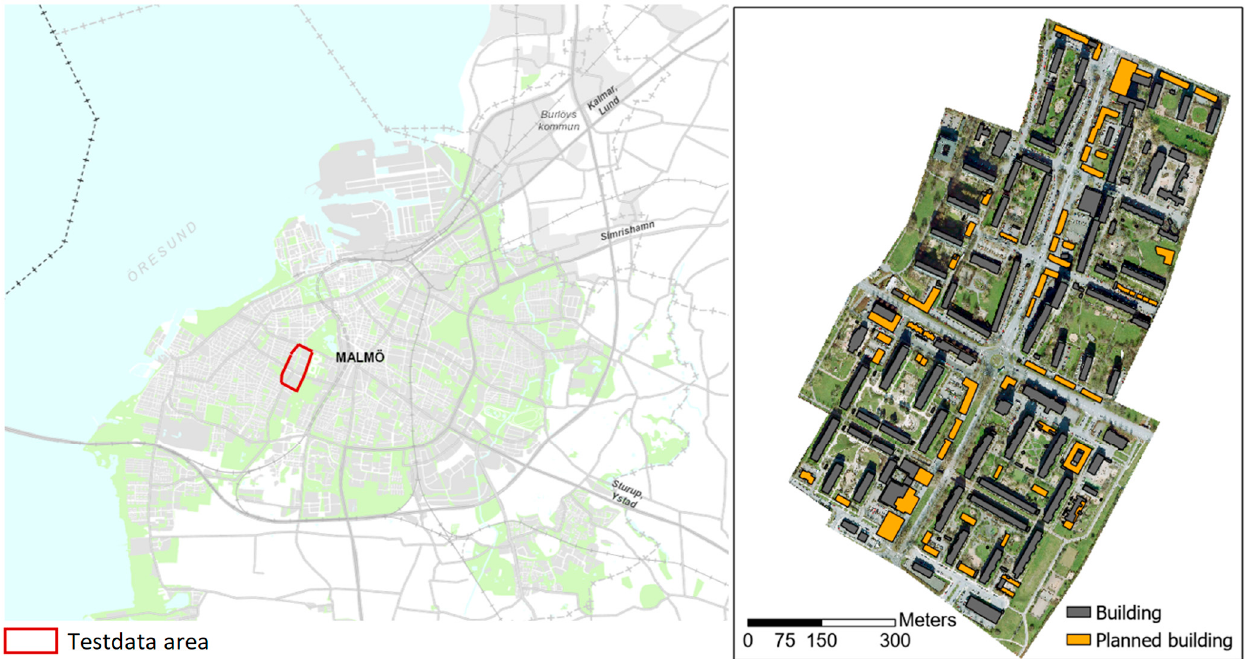
Figure 7. The test area (Lorensborg–Bellevue) in Malmö, for which the 3CIM test data were created. ©Malmö Stadsbyggnadskontor, Malmö stad.